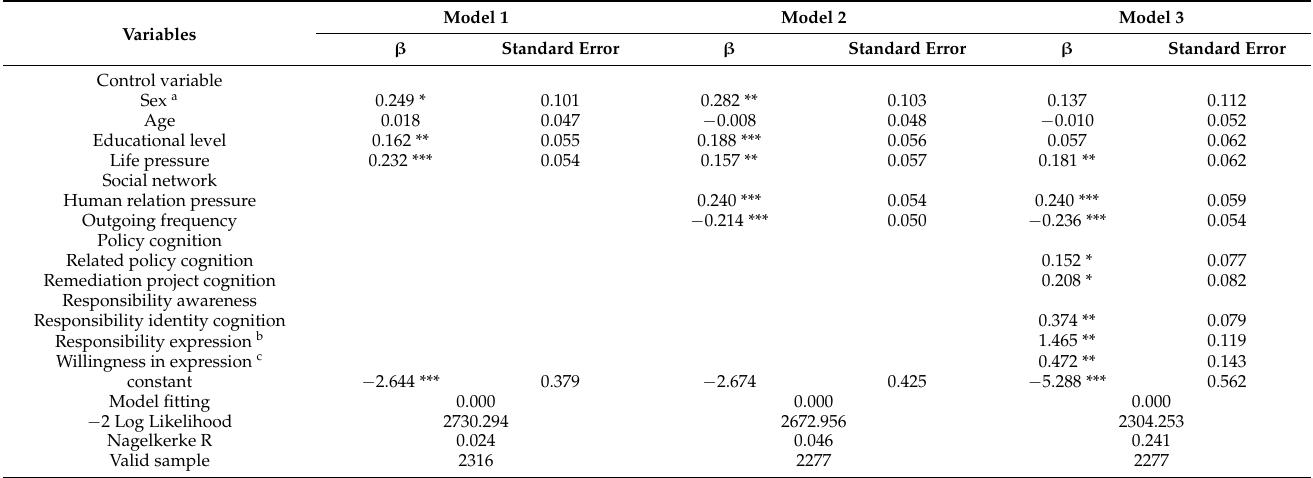
Table 4. Regression analysis of participation in rural health